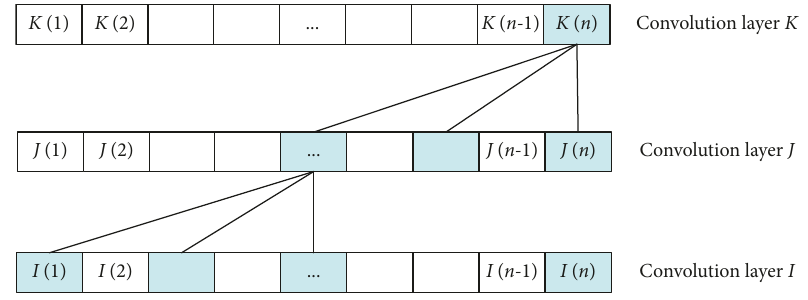
Figure 5: Dilated convolution operation.